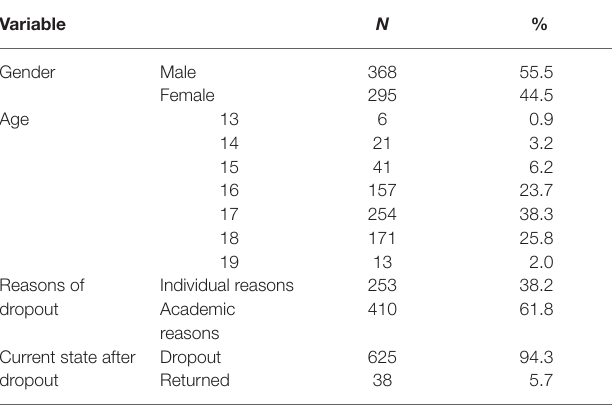
TABLE 1 | Demographic characteristics of participants.